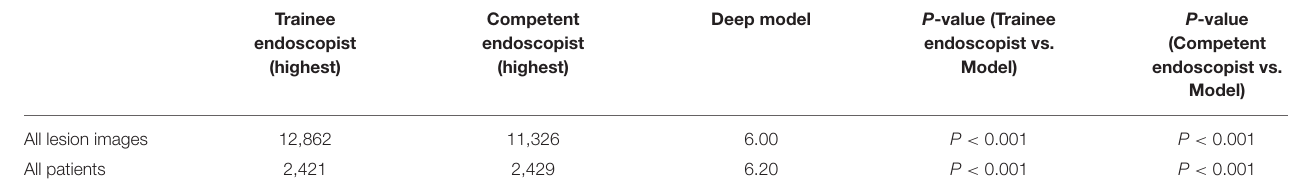
Deep model P -value (Trainee